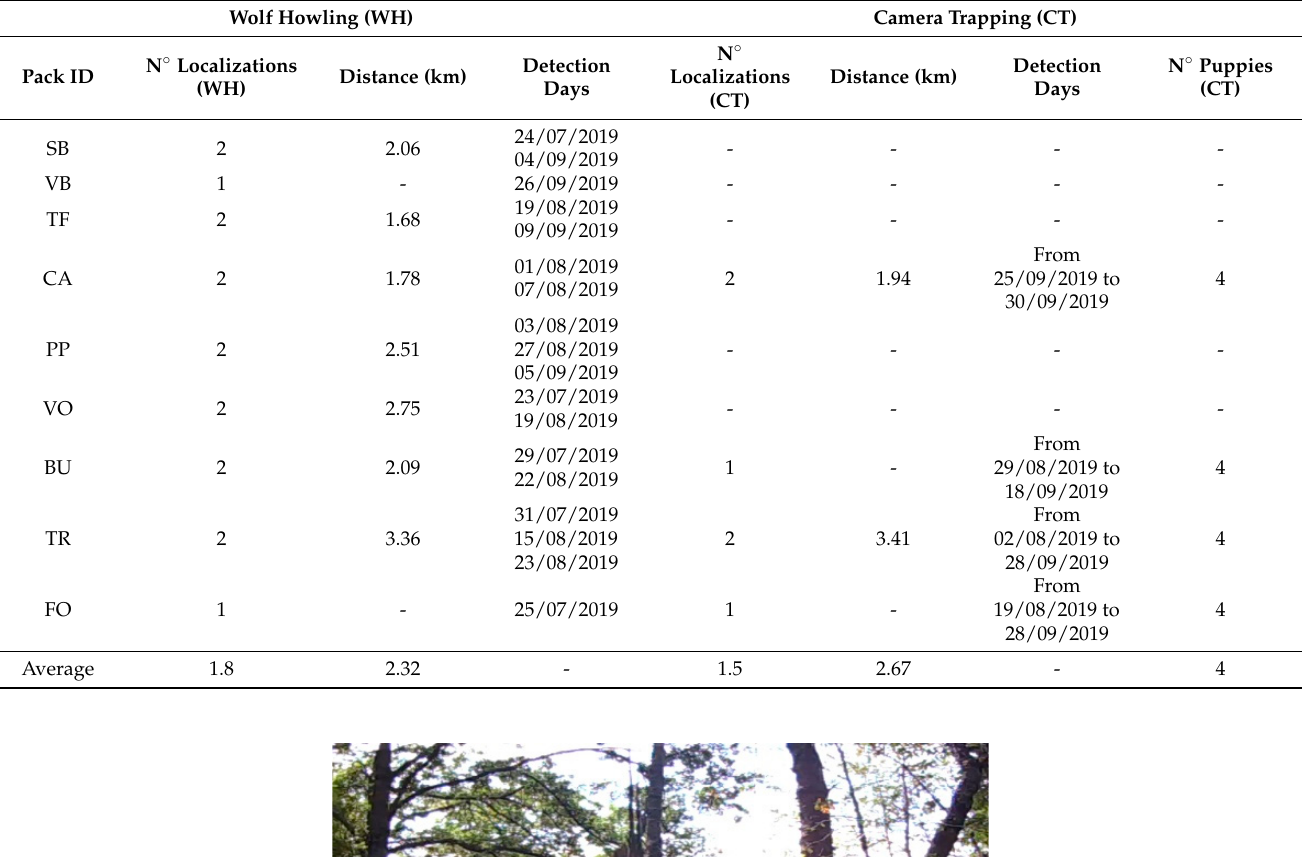
Table 3. Information on pack litters identified by wolf howling and confirmed in IESA by camera trapping.